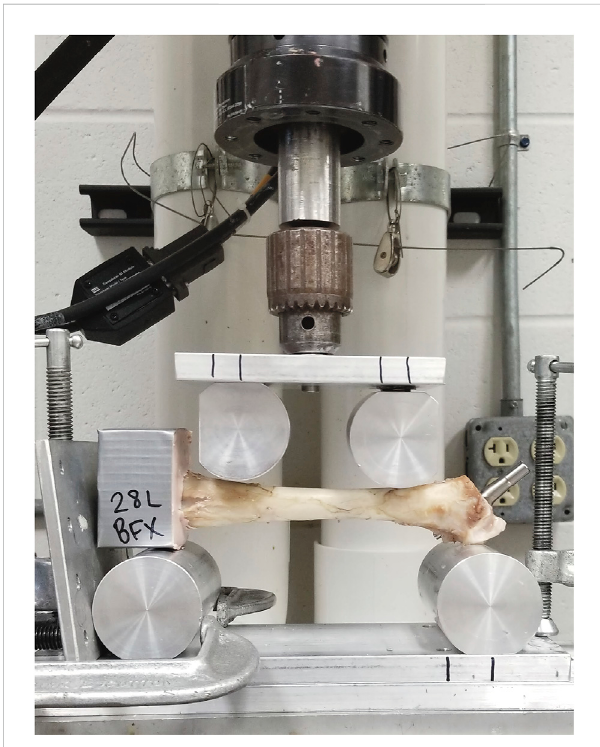
FIGURE 2 Four-point bending fi xture loaded with potted left femur with implanted BFX + lb, prepared for testing in the MTS machine. The cranial aspect of thefemur is facing the camera and thelateral surface of the femur faces down; the protruding portion of the lateral bolt can be seen just distal to the greater trochanter, near the proximal-most support roller.